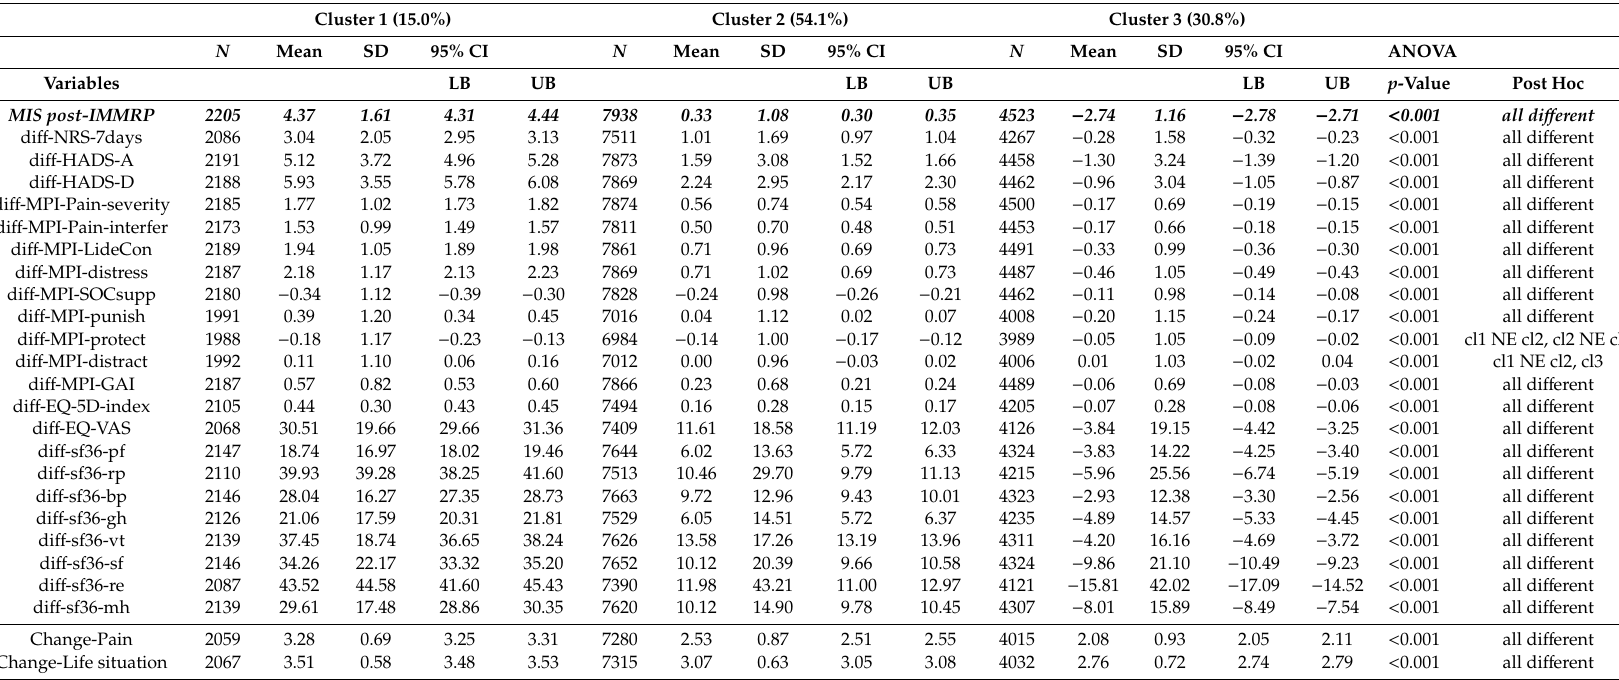
Table 6. Clusters from hierarchical clustering analysis (HCA) based on Multivariate Improvement Score (MIS) ( t -scores) of the first component of the PCA for the changes in outcomes from pre-IMMRP to post-IMMRP (denoted MIS post-IMMRP ). To facilitate understanding, the changes for all the outcomes are shown (mean, SD, and 95% confidence interval). The two bottom rows show the estimations of changes (not included in PCA and the calculation of